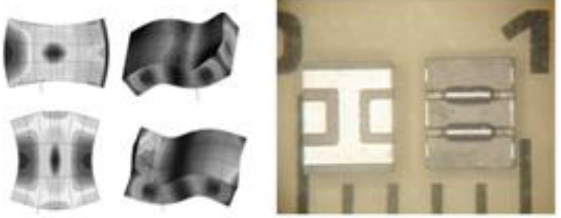
Figure 9. Ultrasonic motor developed by Samsung Electro-Mechanic. Orthogonal dilatational and bending mode shapes ( left ), and a stator element manufactured in multilayer form ( right ) [33].